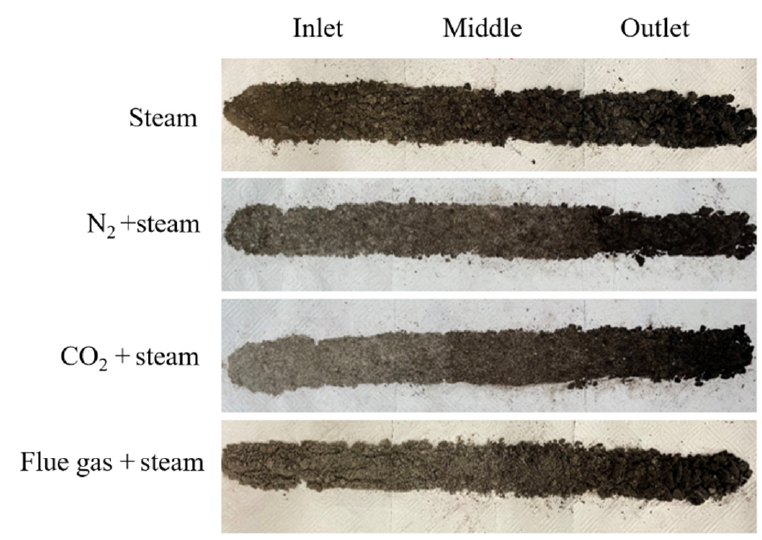
Figure 10. The distribution of the remaining oil under different displacement methods. Table 5. The oil content of oil sands at different positions after displacement. Oil Content/%.